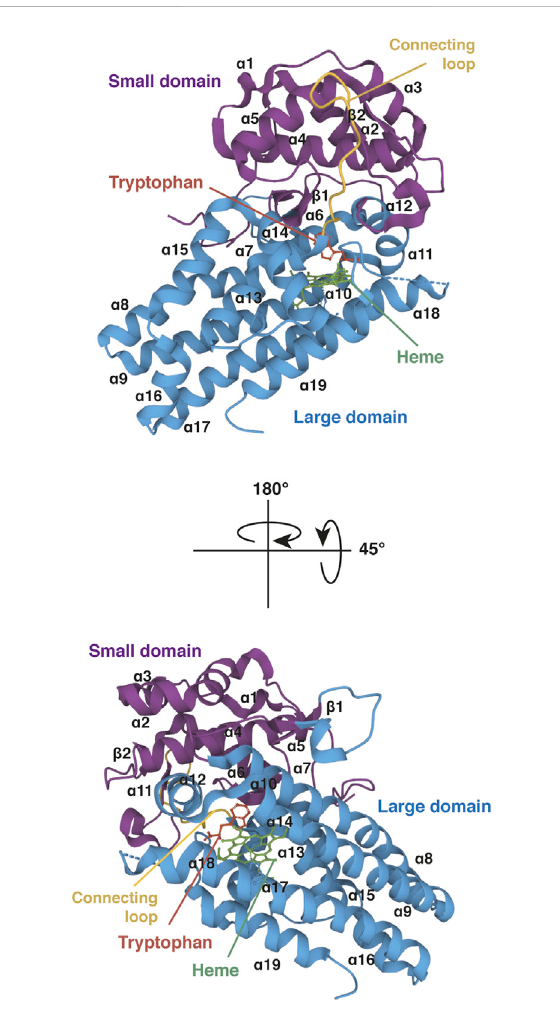
FIGURE 7 Crystal structure of human IDO1 (holo protein). Structure of monomeric IDO1 complexed with tryptophan (red) and the heme cofactor (green) in two orientations. The secondary structure of IDO1 comprises nineteen α -helices and two β -strands assembled in a large domain (blue) and a small domain (purple) arranged on either side of the heme binding site. Both domains are connected together by a long loop (yellow). The heme binding site is surrounded at the proximal side by α -helices 7, 9, 17, and 19 of the large domain and at the distal side by the small domain and the connecting loop. The proximal side refers to the proximal histidine formingacoordinatecovalentboundwiththeironionatthecenterof the heme group, and the distal side to the other side of the heme where iron binds dioxygen. The tryptophan-binding site is shaped by α -helices 11, 12, and 14 of the large domain and the connecting loop, close to the distal side of the heme. The 3D structure of IDO1 was modelized with Mol* Viewer from the crystal structure of IDO1 described by Luo et al. (2018) (PDB fi le ID: